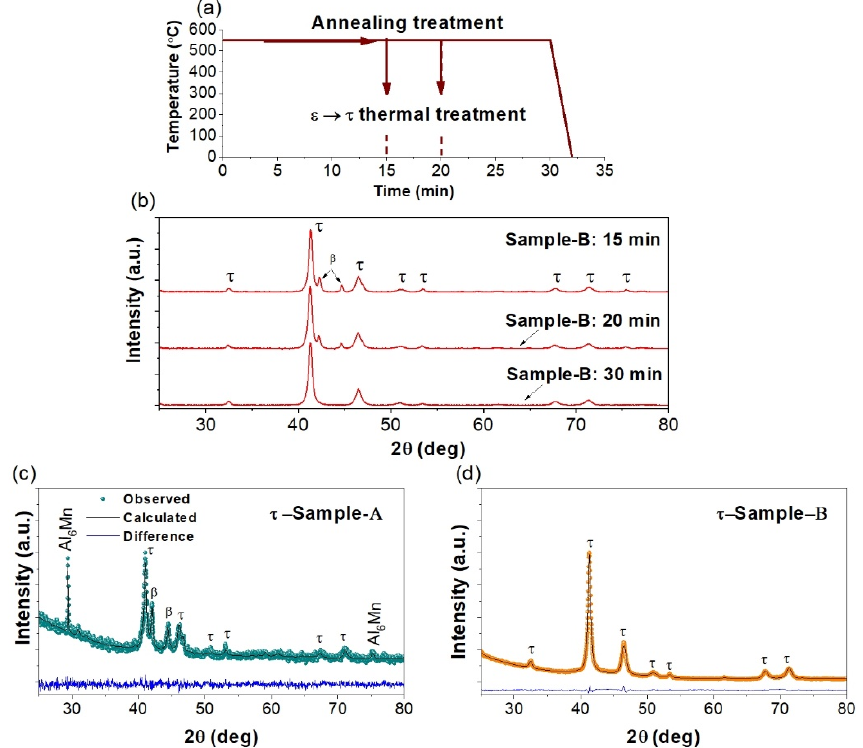
Figure 2. ( a ) Schematic graph of the annealing process to produce the τ -MnAlC at different annealing